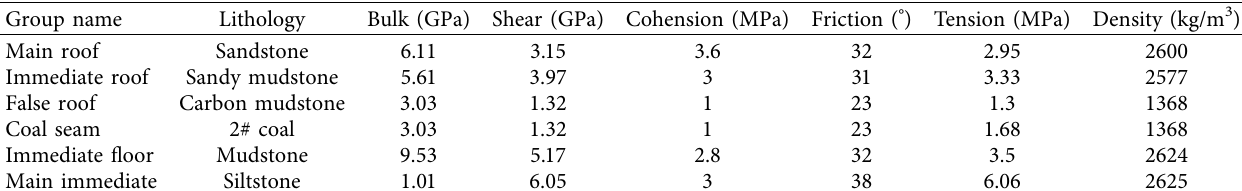
Figure 6: Overall view of the numerical simulation model. Table 1: Main rock model